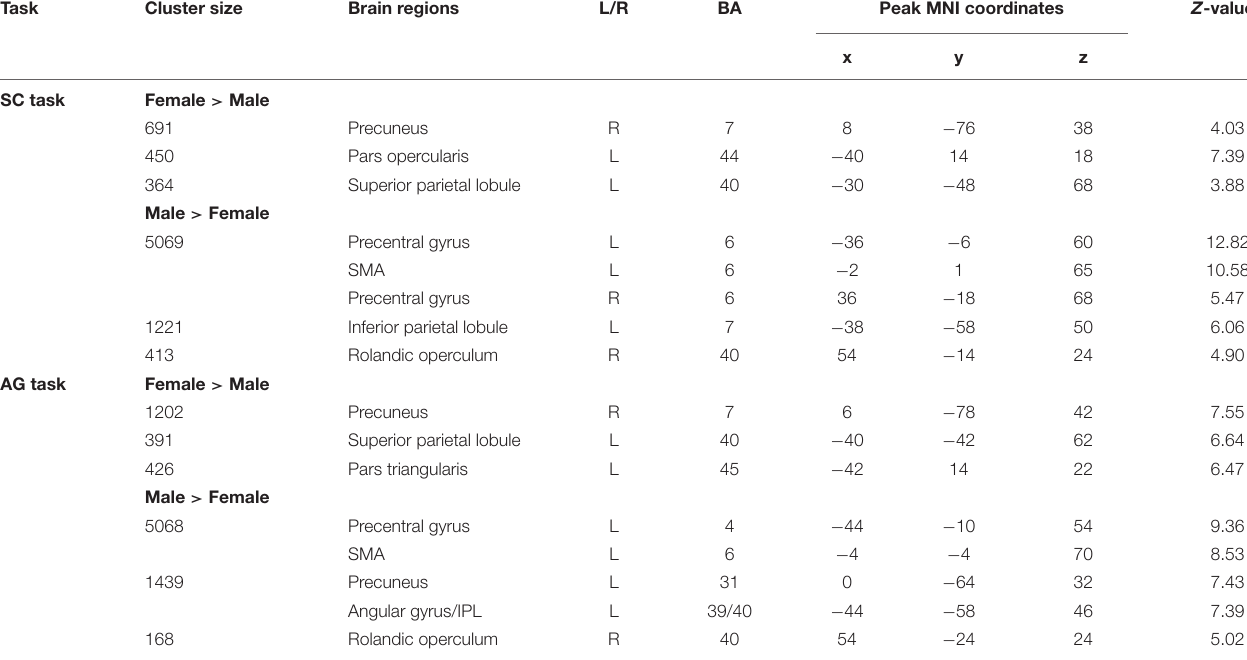
TABLE 3 | Sex differences in each language task ( post hoc analysis).